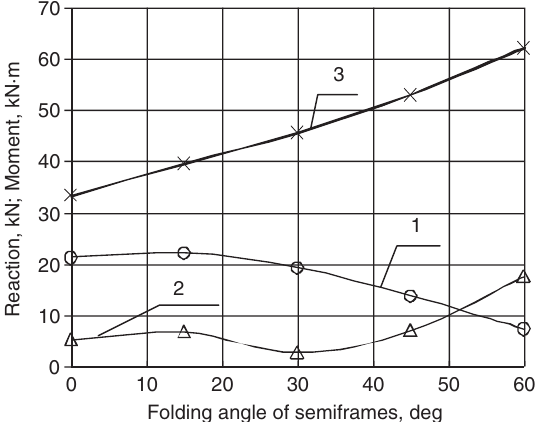
Fig. 4. Changes in the loading of the semi-frames’ hinge joint in the various position on the horizontal plane and boom of the manipulator of 9.3 m: 1 – vertical reaction; 2 – bending moment; 3 – torsional moment